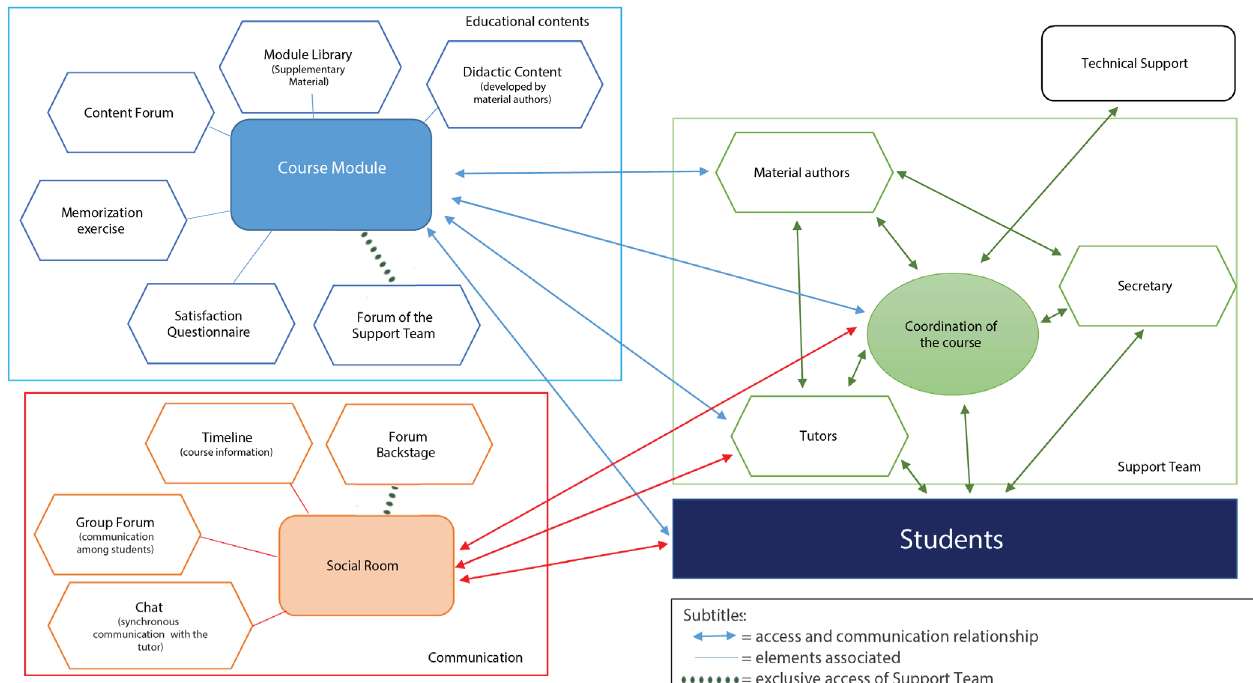
FIGURE 1 - Administrative, didatic and academic struture of Training Course on Dispensing